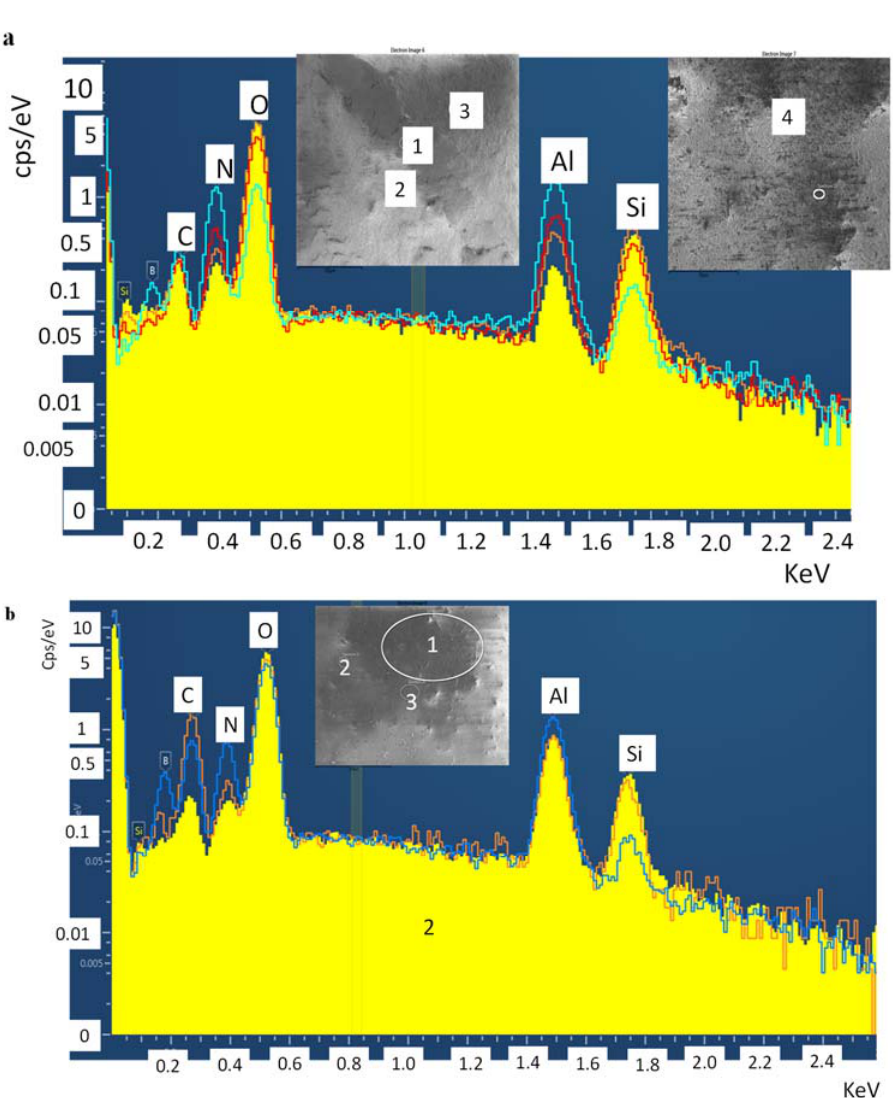
Figure 9. SEM-EDS spectra of various areas in and around the tribological tracks of S3 ( a ) and S20 ( b ). The presence of Al, O, N can be detected in both the samples along with residuals like Si (from abrasion of Si 3 N 4 counterpart) and C (from carbon tape in SEM).